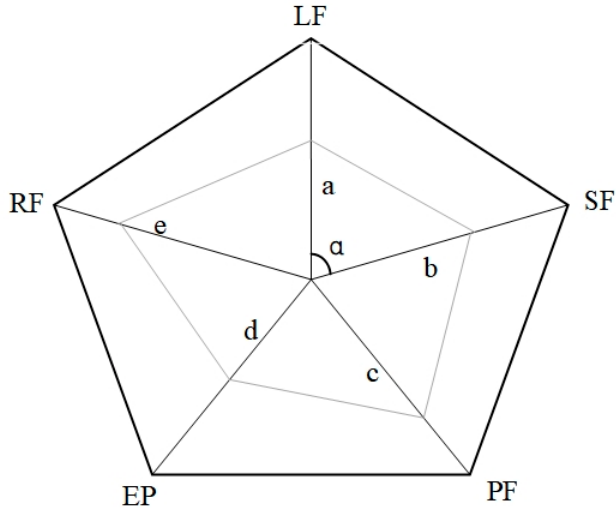
Figure 2. Polygonal map of rural residential land function.